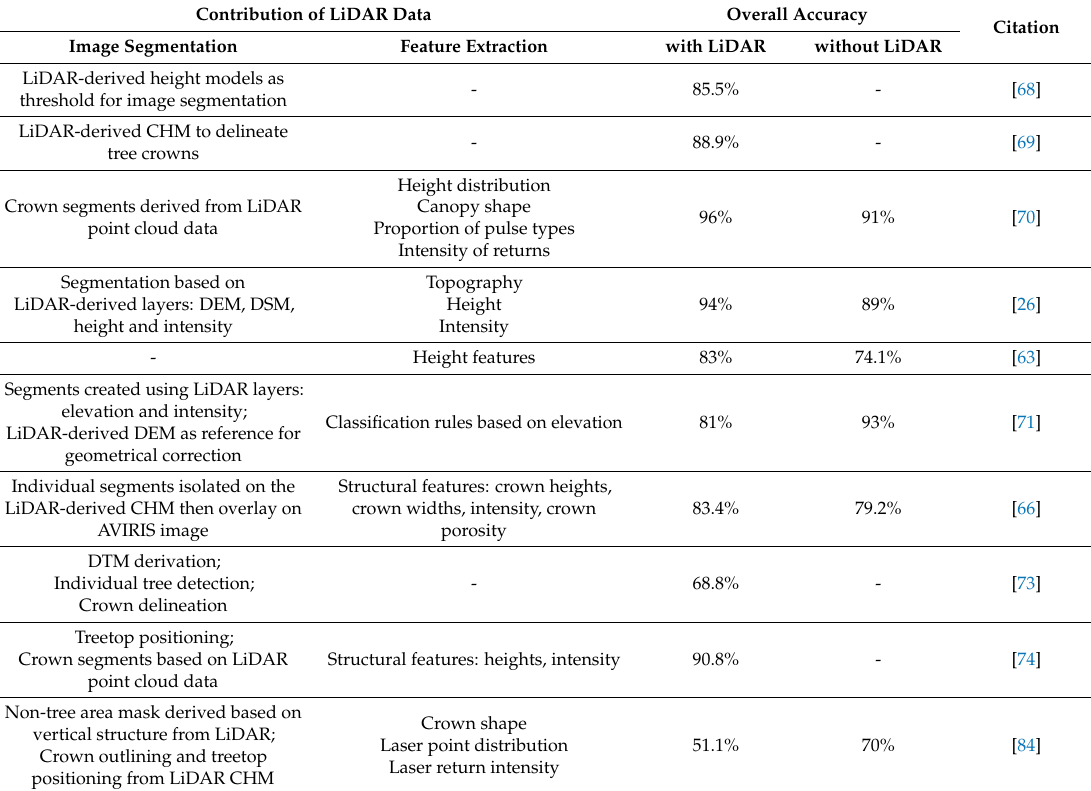
Table 1. Summary of contributions of LiDAR in tree species